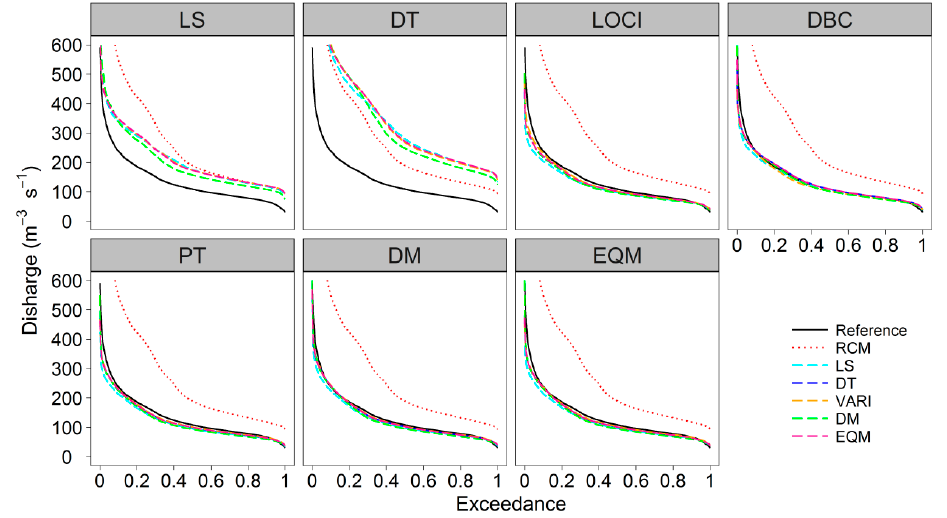
Figure 11. Exceedance probabilities of discharge between 1986–2004 periods grouped by precipitation bias-corrected methods. bias-corrected